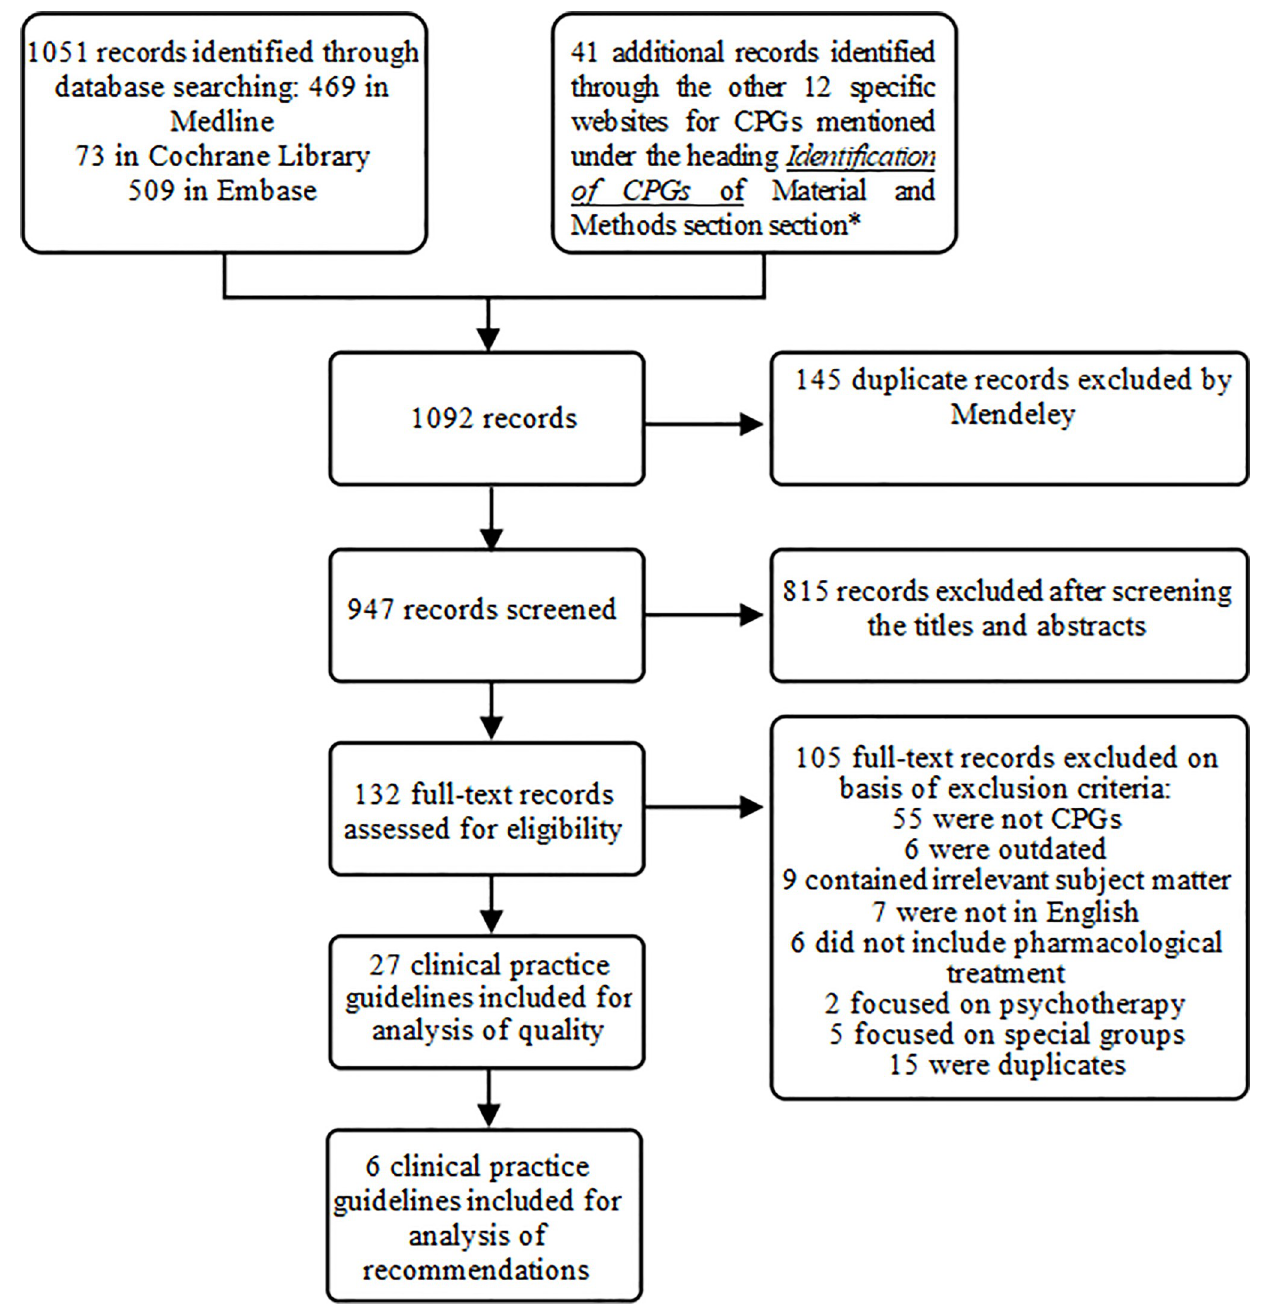
Fig 1. Flowchart of clinical practice guidelines